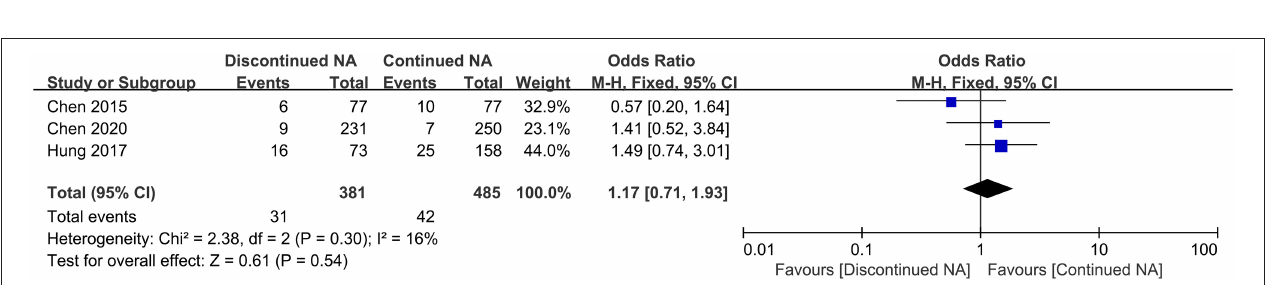
FIGURE 3 | Forest plot on serological outcomes and virological outcomes comparing between continued Nucs therapy and discontinued Nucs therapy. (A) virological bound; (B) undetectable HBV DNA level; (C) HBsAg loss.